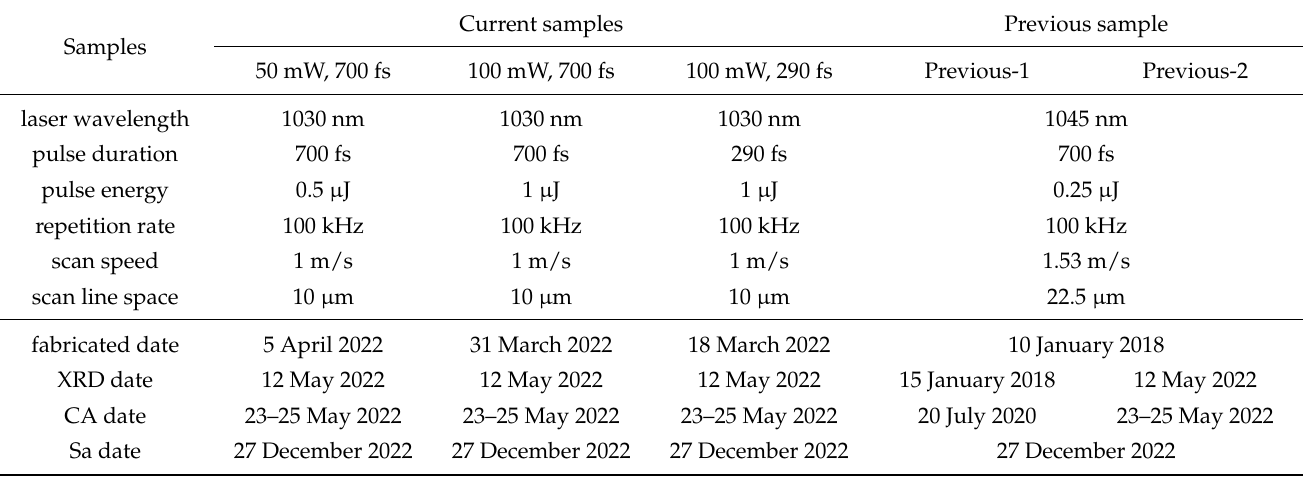
Table 1. The details of fabrication conditions and experiment date. These samples were kept in sample cases which were stored in a desiccator, and a clean tweezer was used to pick these samples when they needed to be